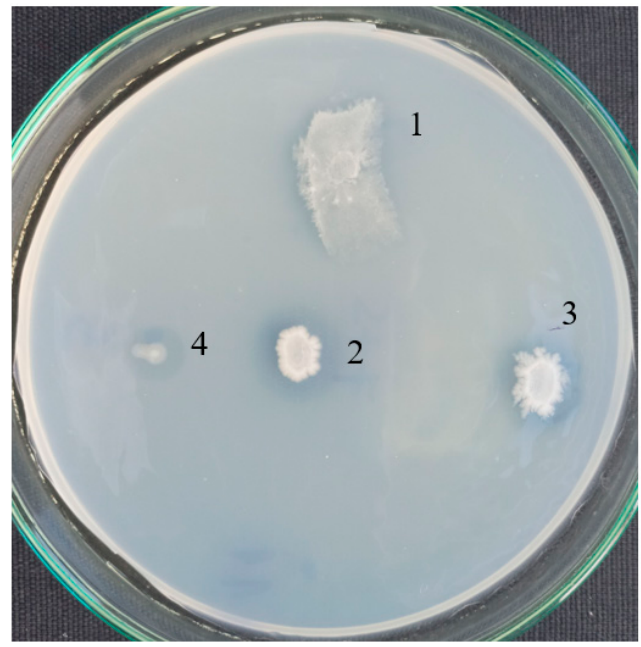
Figure 2. Clear halo by PCL-degrading bacteria isolated from Marikostinovo. 1, MKC-P; 2, Brevibacillus thermoruber strain 7; 3, Aneurinibacillus thermoaerophilus strain 2; 4, Meiothermus cateniformans strain 12.